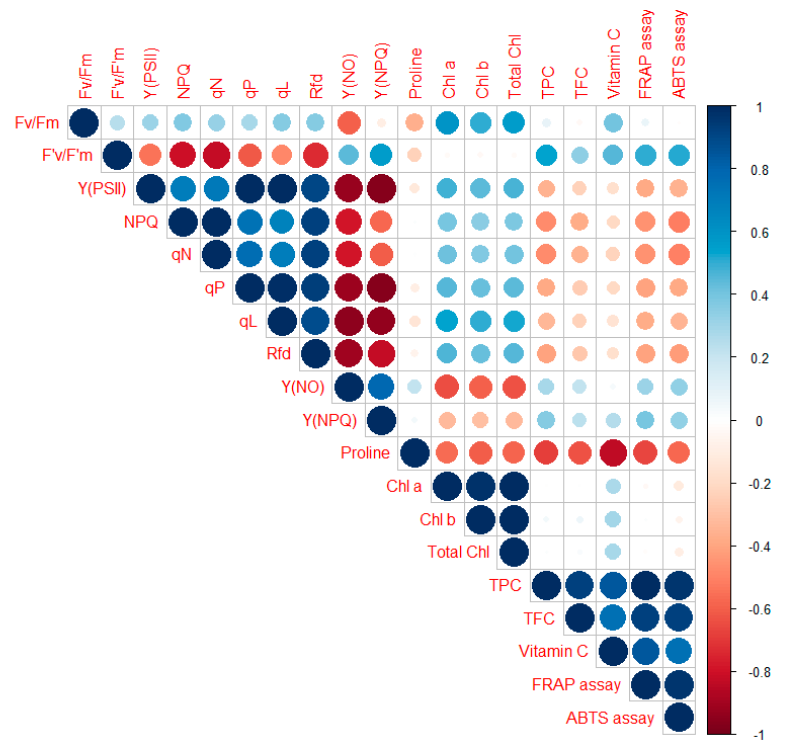
Figure 5. Correlation analysis for chlorophyll fluorescence parameters, nutritional compounds and antioxidant activities in lettuce seedlings regardless of treatment length and NaCl concentration. Blue circles represent positive correlations whereas red circles represent negative correlations. Color intensity and circle size are proportional to the correlation coefficients, which are shown in the legend to the right. Chl: chlorophyll, TPC: total phenol content, TFC: total flavonoid content, FRAP: ferric reducing antioxidant power; ABTS: 2,2 ′ -azino-bis (3-ethylbenzothiazoline-6-sulfonic acid). Refer to the Table 1 for detailed information on CF parameters.